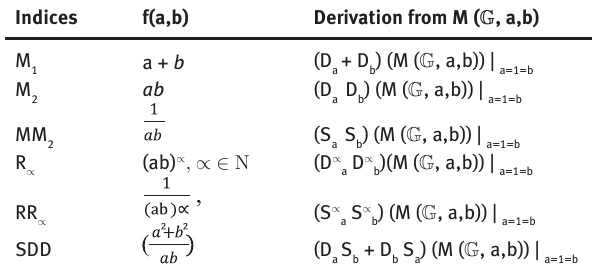
Table 1: Relation between M-polynomial and TIs